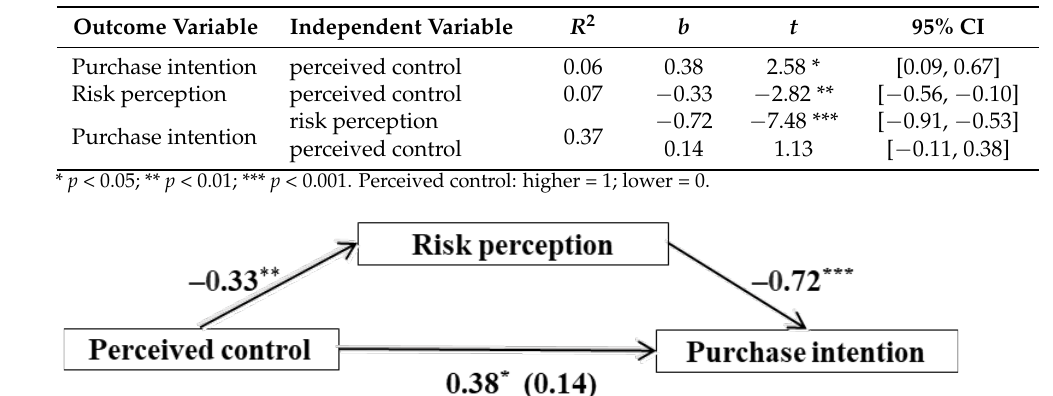
Table 4. Study 2 mediation effects analyses ( N = 115).